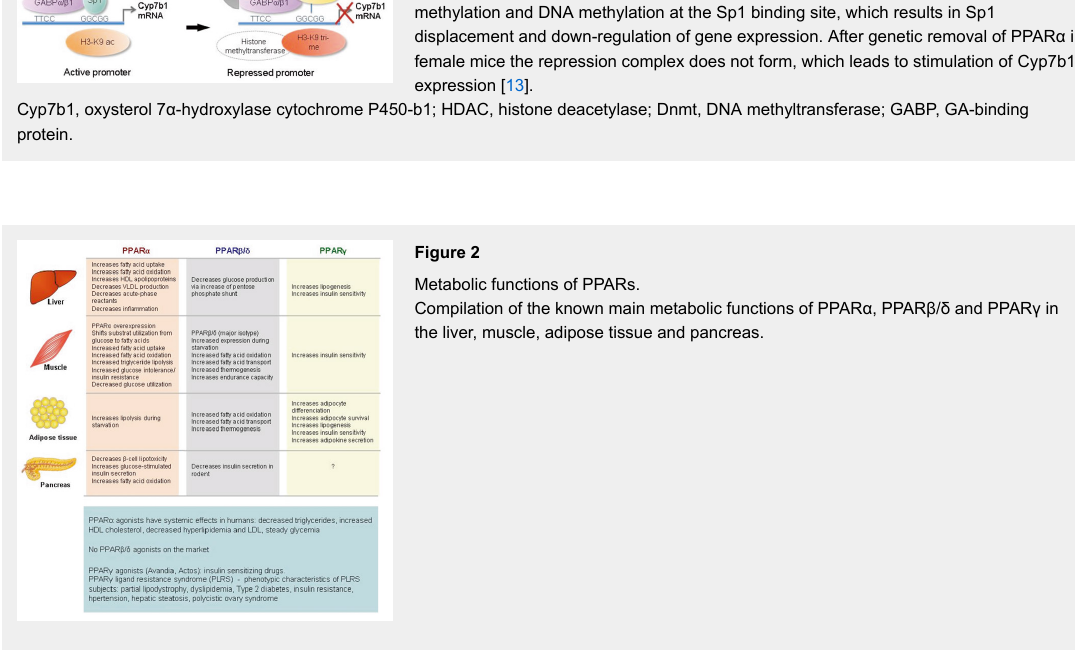
Sumoylation-dependent transrepression by PPARα is sex-dependent. A.) Model of the ligand-binding domain (LBD) of mouse PPARα in the ligand-activated conformation (upper left panel). Lysine 358 (K358) in Helix 7 of the LBD of PPARα is sumoylated in female hepatocytes and is presented at the surface of the LBD upon agonist binding. This lysine is conserved in the corresponding position of Helix 7 of PPARγ and PPARβ/δ (upper right panel). The change of conformation of Helix 12, which is induced by a PPARα agonist, increases the accessibility of K358 for sumoylation (lower left panel). In contrast, K358 is masked in the presence of an antagonist (lower right panel). The NH-end helix (Helix 1) and COOH-helix (Helix 12) of the ligand binding domain are in pink, Helix 7 with its sumoyalated lysine (K358) in red and the β-sheets in orange. B.) Model of PPARα-induced repression of Cyp7b1 in females. Sumoylation of PPARα promotes interaction with GABPs and leads to the recruitment of NCoR, HDACs, histone and DNA methyltransferases. These events lead to histone H3 deacetylation, tri- methylation and DNA methylation at the Sp1 binding site, which results in Sp1 displacement and down-regulation of gene expression. After genetic removal of PPARα in female mice the repression complex does not form, which leads to stimulation of Cyp7b1 expression [13].